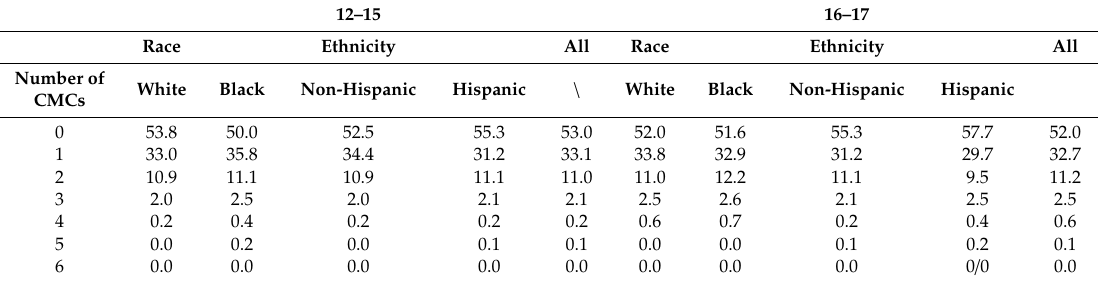
Table A1. Distribution of Chronic Medical Conditions (CMCs) by race, ethnicity, and